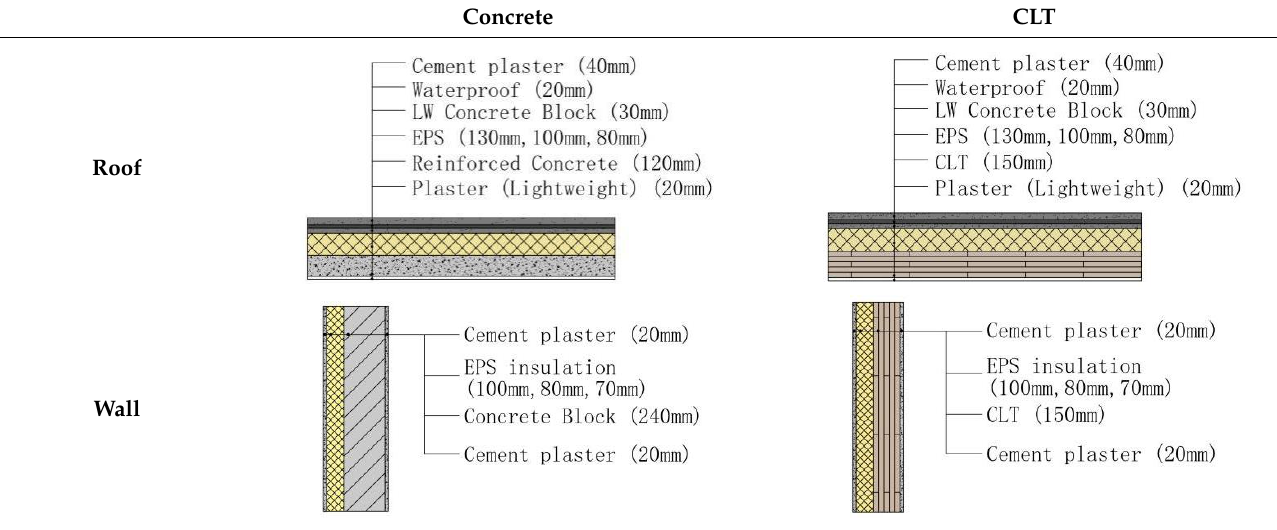
Table 5. Details of roof, external wall, and ground design.